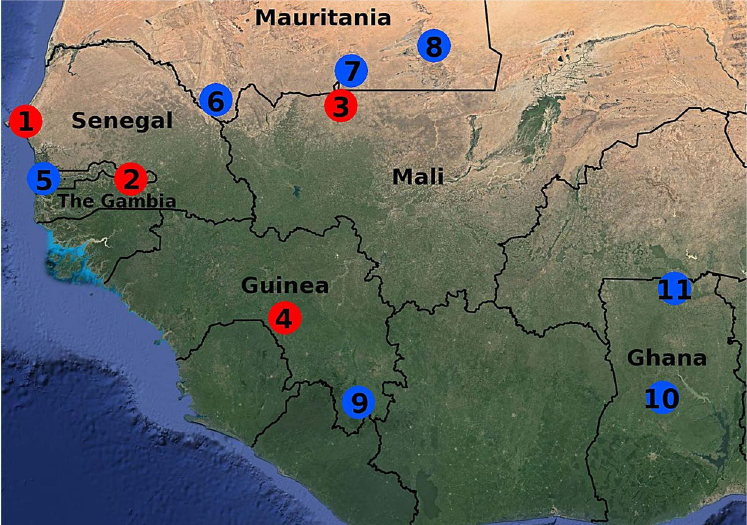
Figure 1. Locations of Plasmodium falciparum population samples from West Africa with genome sequences analysed in this study. Red points mark the location of the four newly sampled sites (1, Pikine in Senegal, 60 infections sequenced; 2, Basse in The Gambia, 113 infections sequenced; 3, Nioro in Mali, 52 infections sequenced; 4, Faranah in Guinea, 59 infections sequenced), and blue points indicate locations of previous population samples with which these were compared (5, Greater Banjul in The Gambia; 6, Selibaby in Mauritania; 7, Kobenni in Mauritania; 8, Nema in Mauritania; 9, N ′ Zerekore in Guinea; 10, Kintampo in Ghana, 11, Navrongo in Ghana). Further details are given in Table 1. Satellite image view shows diverse levels of vegetation cover due to varying amounts of annual rainfall across the region, reproduced with permission